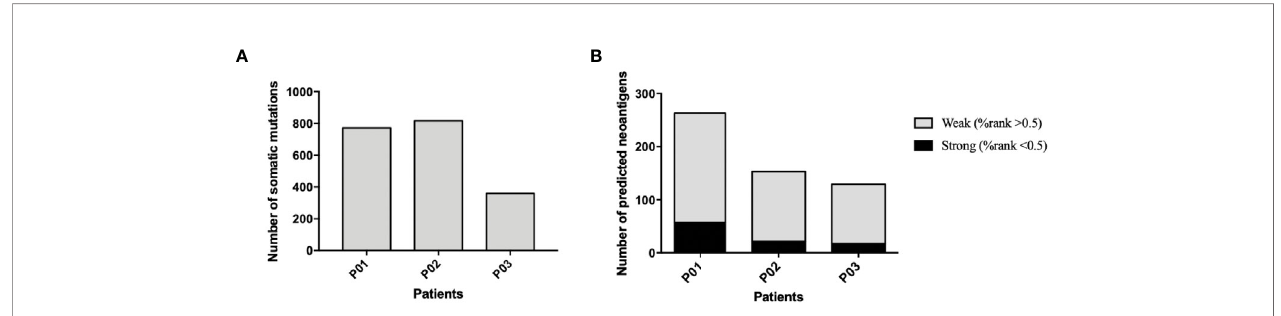
FIGURE 1 | Frequency of somatic mutations and predicted neoantigens in 3NSCLC patients. (A) WES and RNA-seq were performed in 3 patients with NSCLC. Tumor-speci fi c non-synonymous somatic mutations were identi fi ed. The frequency of somatic mutations of each patient is shown. (B) Neoantigen prediction was performed for each patient. The frequency of neoantigens as well as strong binder (%rank <0.5) and weak binder (0.5< %rank <2) of each patient is